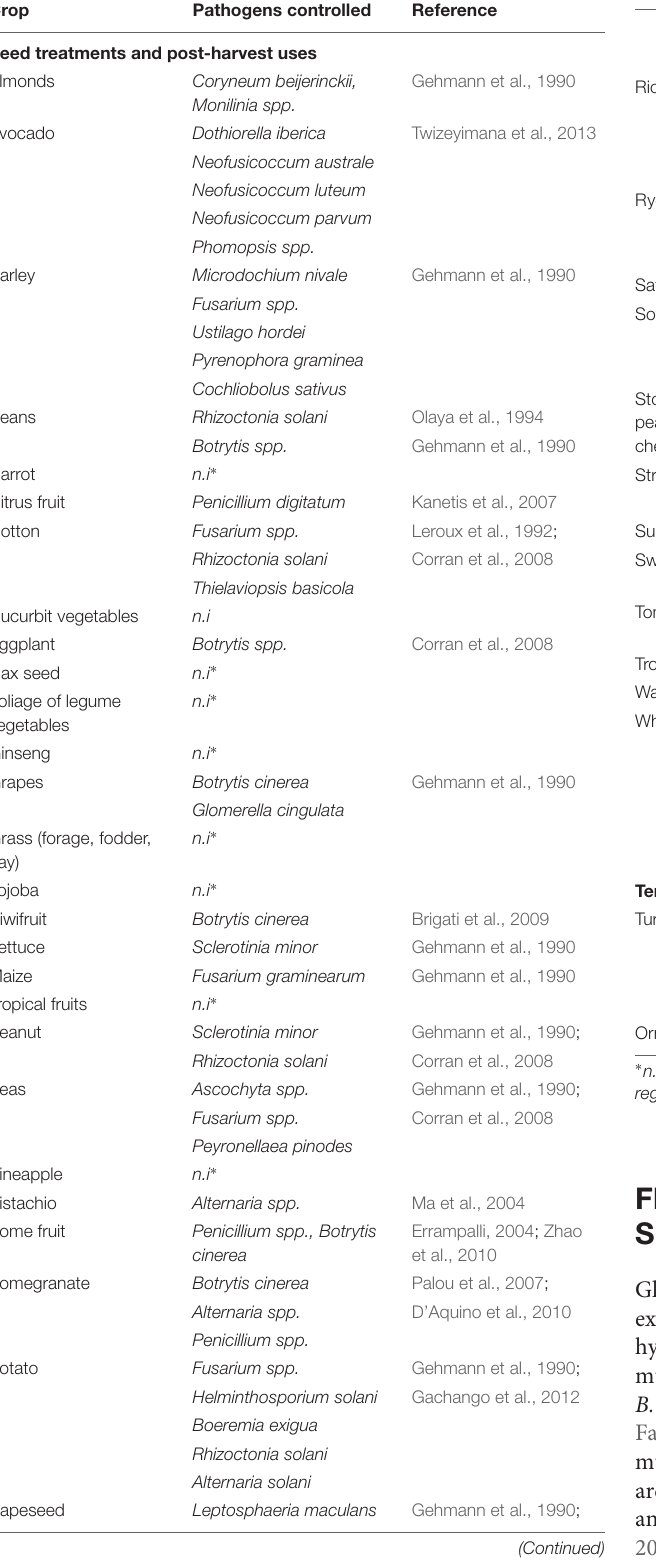
TABLE 1 | Crops and diseases registered for pre- or pos-tharvest treatment with phenylpyrroles.